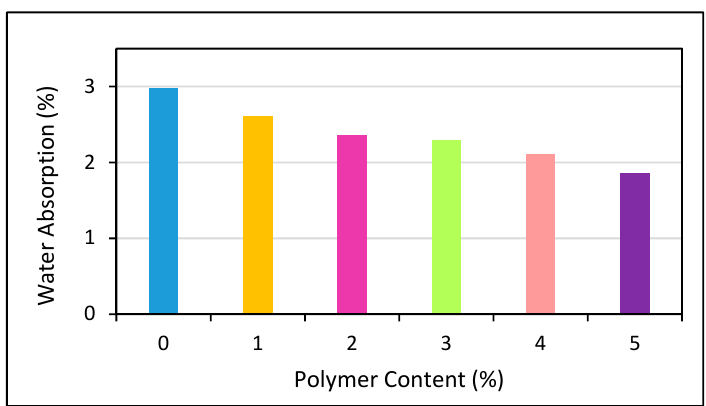
Figure 17. Water absorption of a concrete mix at various polymer to cement ratios [251].